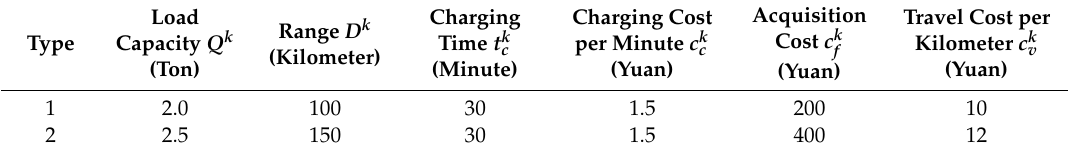
Table 1. Parameters of electric